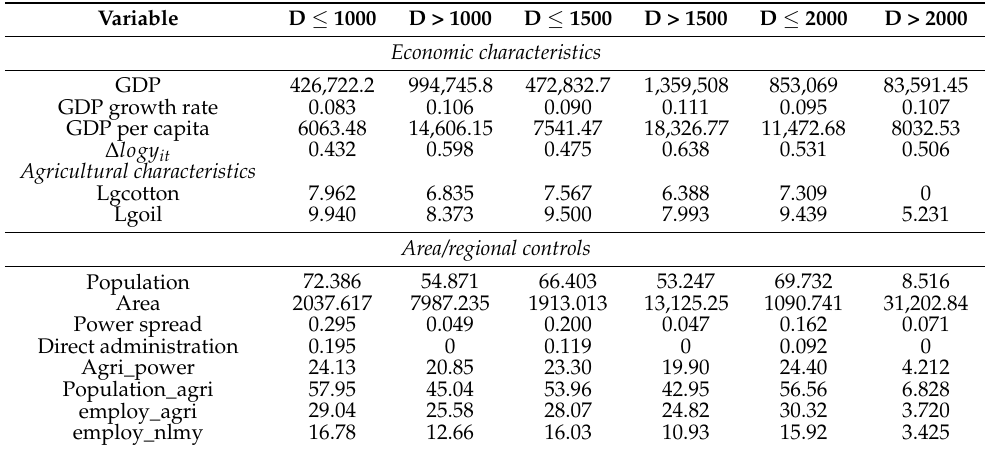
Table 5. More details of the treatment group (Average data values of different distances away from the dam